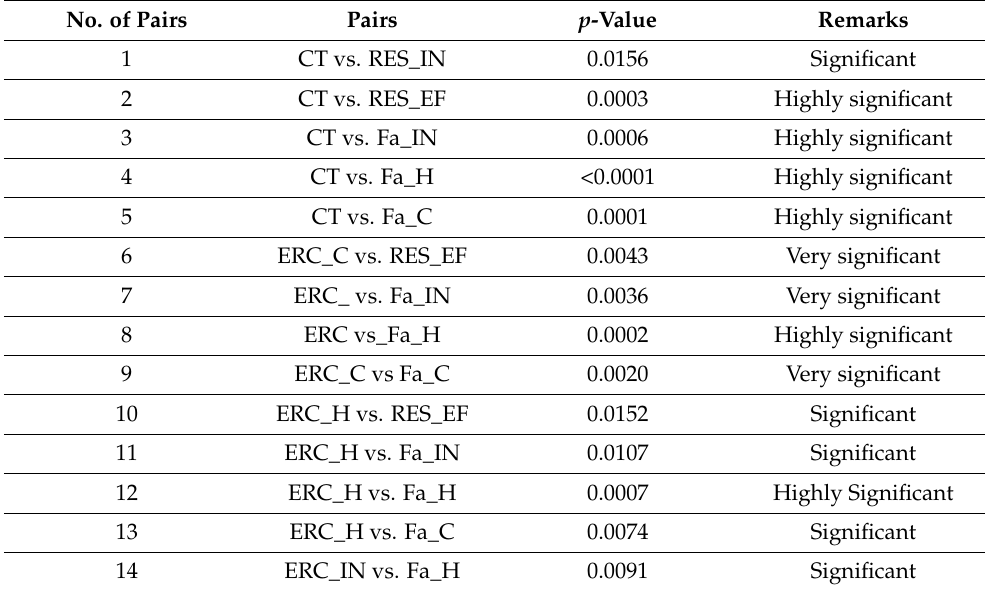
Table 3. Detailed description of the ANOVA results for the significant pairs shown in Figure